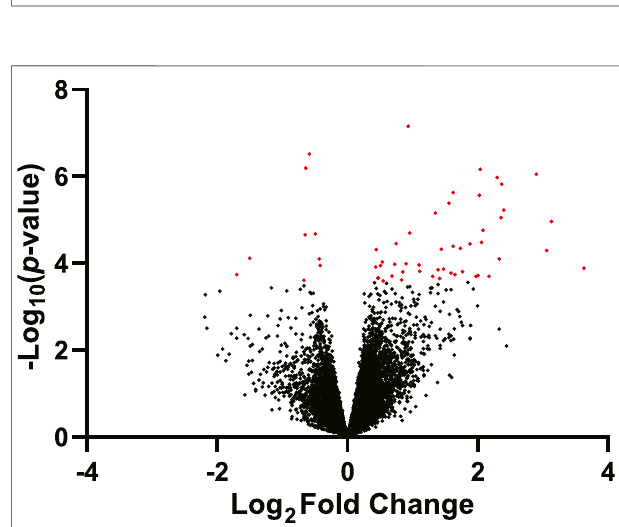
FIGURE 2 | Volcano plot of differentially expressed genes in the mammarygland ofmice treatedwith fl uoxetine (20 mg/kg/d, n =8)compared to saline control ( n = 8). The y-axis denotes the − log 10 p -value for each gene, while the x-axis denotes the log 2 fold change for that gene relative to fl uoxetine treatment. Red dots indicate signi fi cantly changed genes in the fl uoxetine treatment group (FDR ≤ 10%); black dots indicate non-signi fi cantly changed genes or FDR ≥